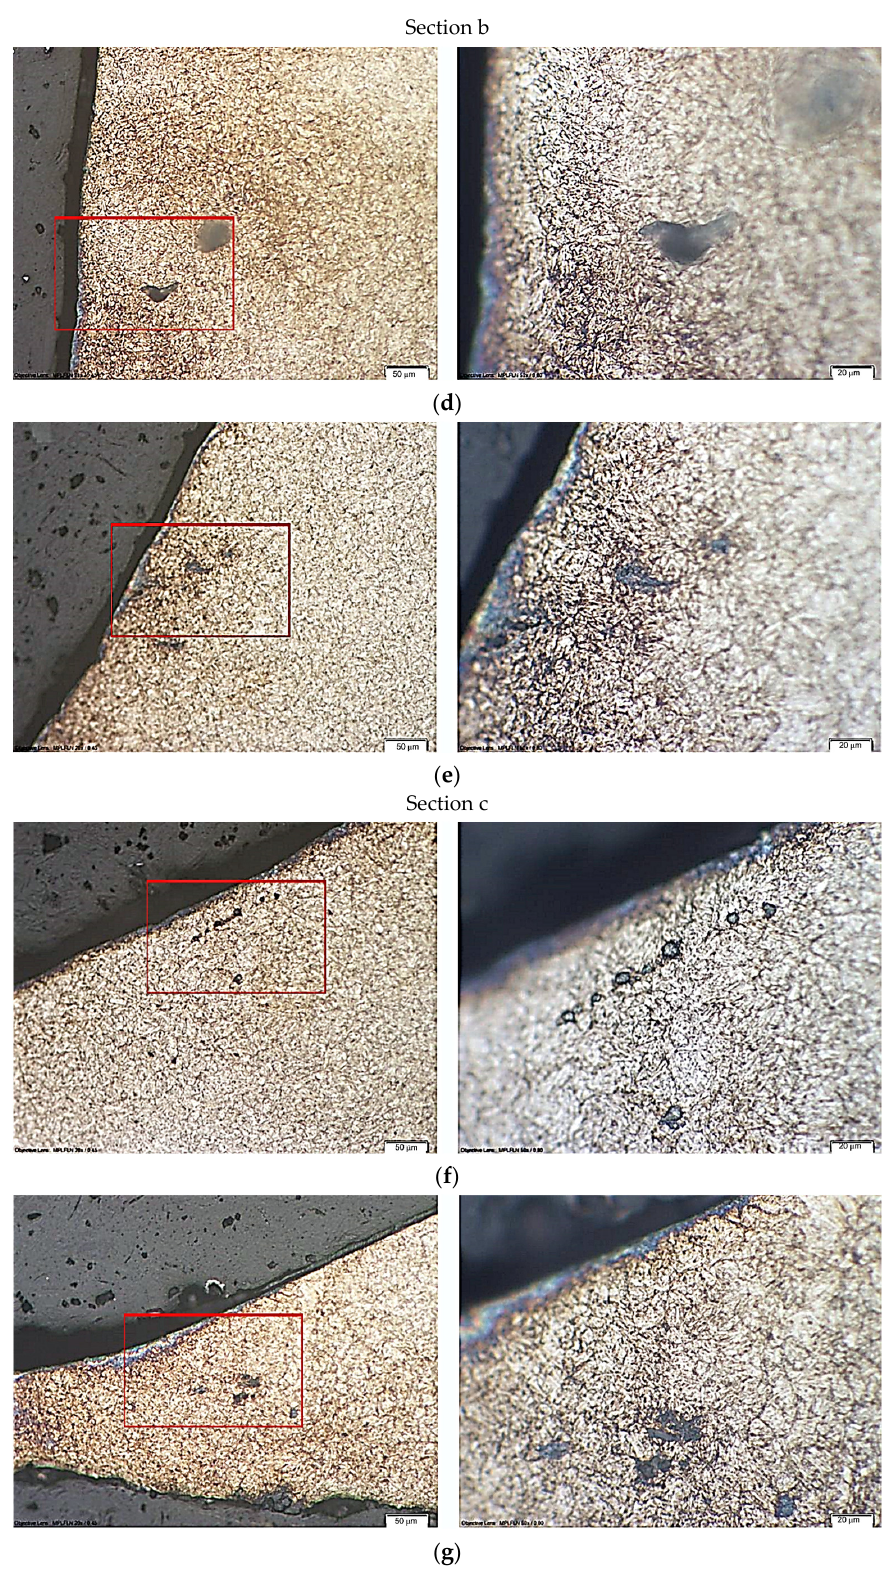
Figure 7. Microstructure of the investigated die insert in the near-surface layer with image magnifica- tion (area marked with red box): ( a ) areas selected for the analysis, ( b ) observation area 1 section a, ( c ) observation area 2 section a, ( d ) observation area 1 section b, ( e ) observation area 2 section b, ( f ) observation area 1 section c, ( g ) observation area 2 section